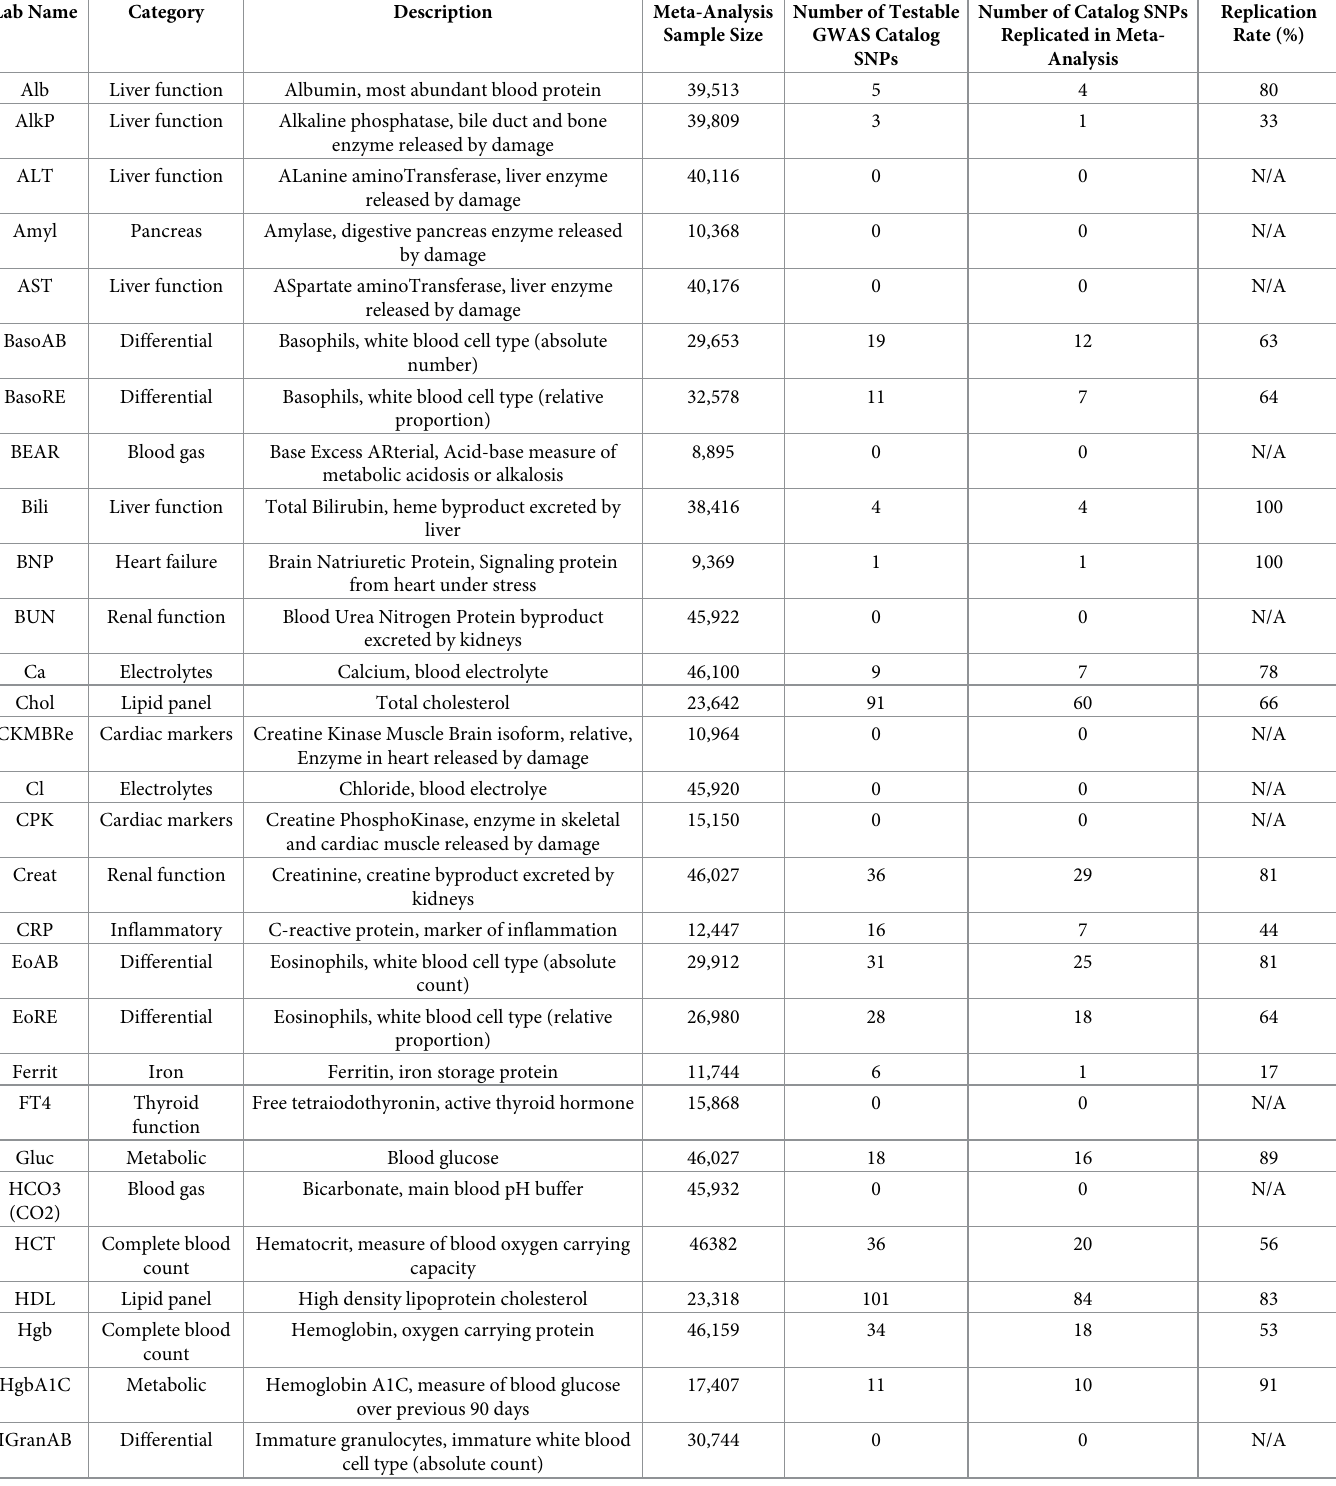
Table 1. Summary of clinical lab traits tested, including meta-analysis samples size, number of testable GWAS catalog SNPs, number of replicated catalog SNPs and replication